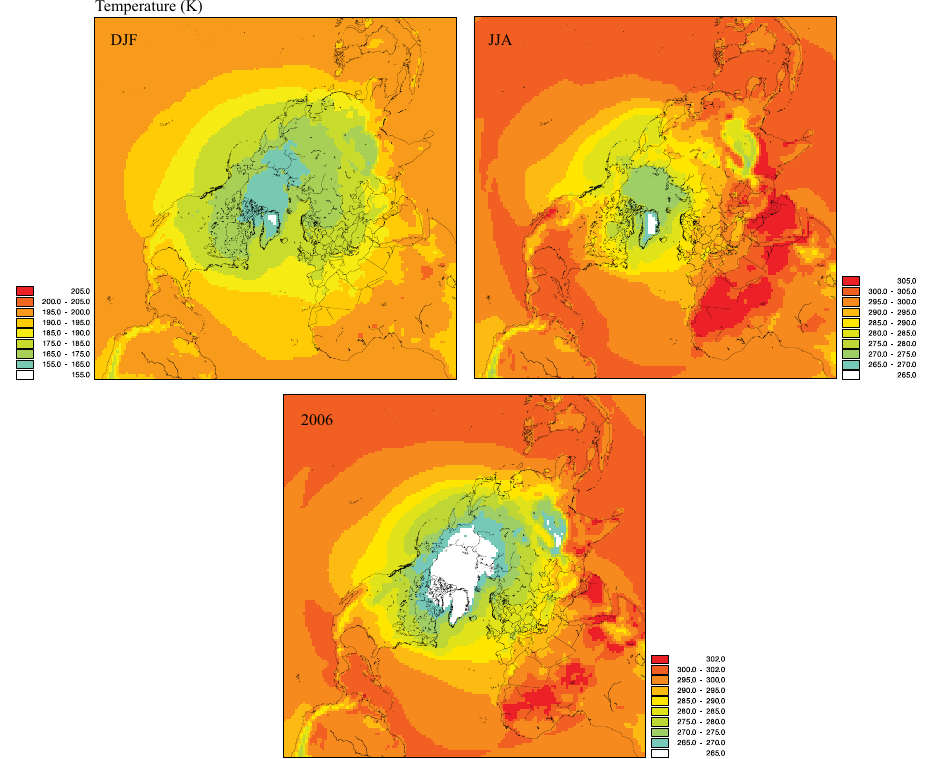
Fig. 7. Mean temperature pattern of the lowest model layer provided by MM5v3.7 in 2006; the entire year, summer (JJA) and winter (DJF).